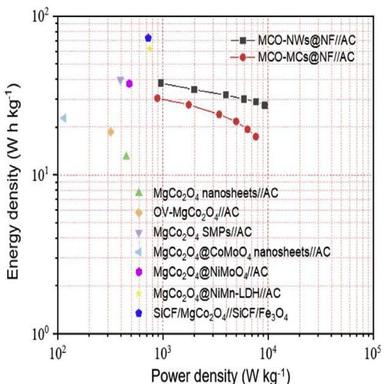
e Ragone plots of MCO-NWs@NF//AC HSC, MCO-MCs@NF//AC HSC, and some other HSCs reported previously for a comparison.